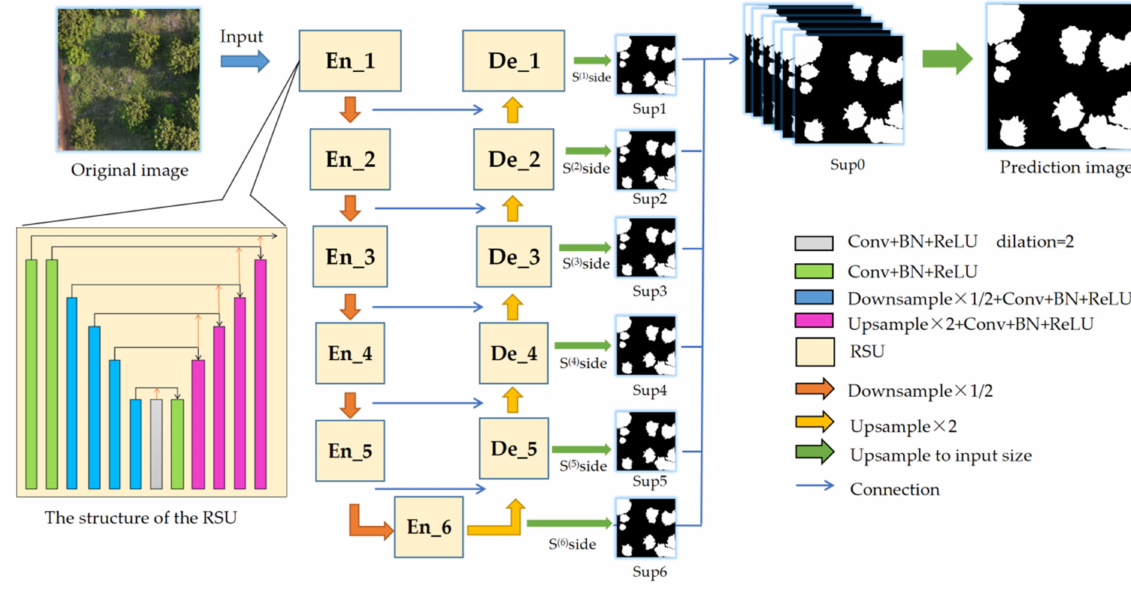
Figure 7. Structure of the U 2 -Net model. En represents the encoder, De represents the decoder, S (n) side represents the side output saliency maps, and Sup represents the upsampling